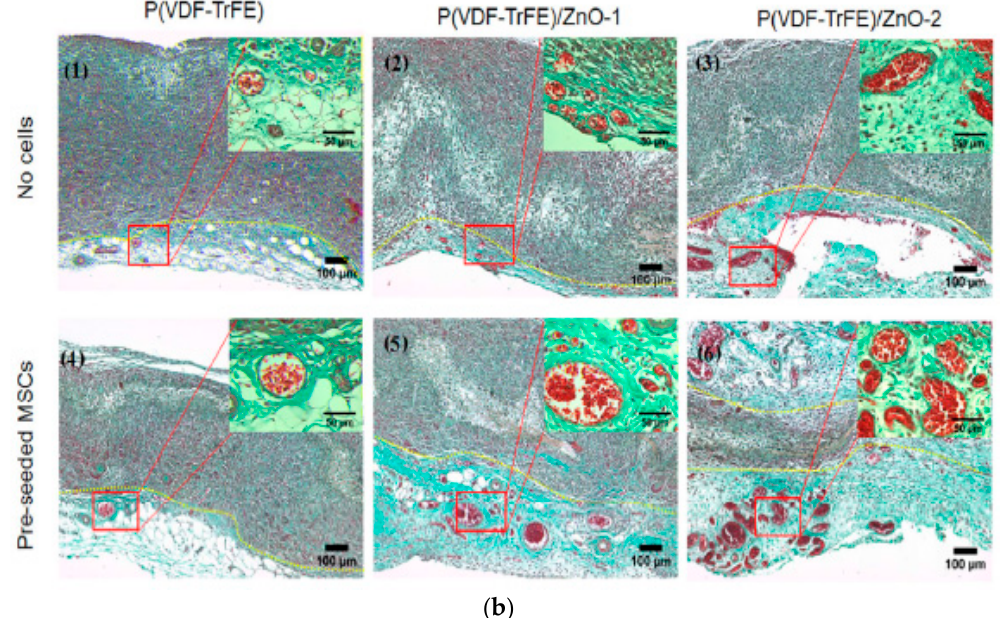
Figure 27. ( a ) Schematic showing the fabrication of electrospun P(VDF-TrFE) and P(VDF-TrFE)/ZnO scaffolds, hMSC seeding, and subsequent implantation into Wistar rats. ( b ) Histological examinations of fibrous scaffolds with or without pre-seeded hMSCs after implantation in rats for 7 days, and stained with Masson’s trichrome. Blood vessels developed in connective tissue adjacent to scaffolds as distinguished by yellow dashed lines, and collagen was found in all scaffolds (green). P(VDF-TrFE)/ZnO-1 and P(VDF-TrFE)/ZnO-2 contained 1 wt% and 2 wt% ZnO, respectively. Reproduced